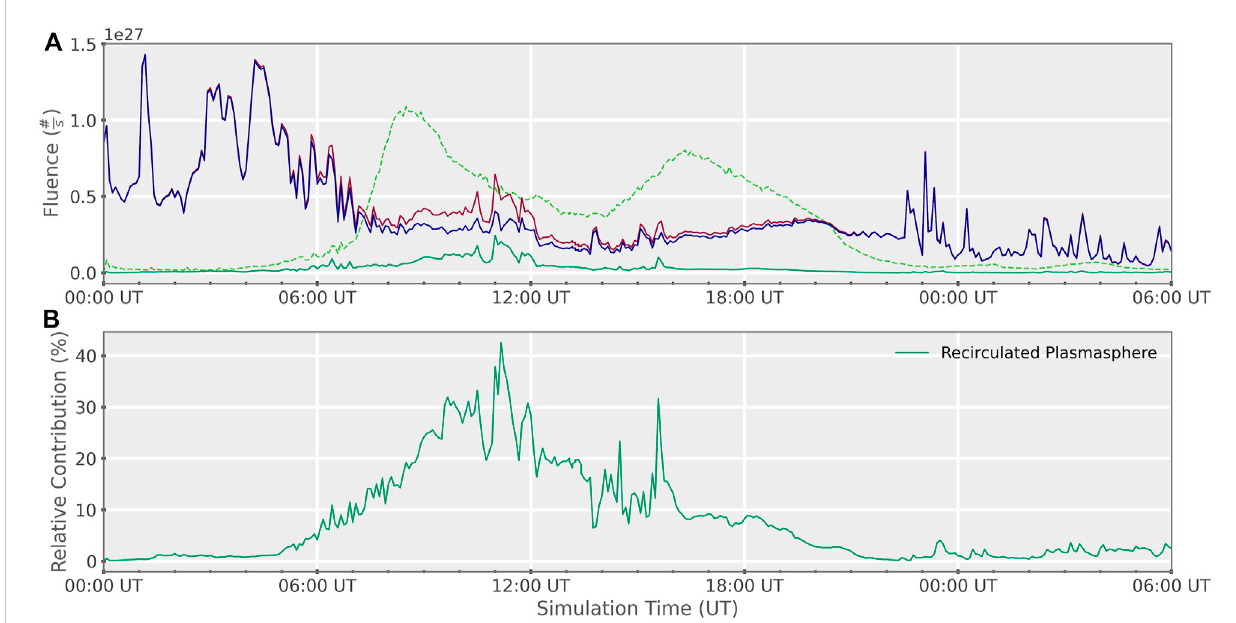
FIGURE 11 (A) Fluence of the BATS-R-US fl uids as they cross the measurement boundaries on the day and night side 1. “ Dayside Plasmasphere ” corresponds to the fl uence of the plasmasphere material through the dayside plume. “ Total Night Side ” refers to the total fl uence of all fl uids passing through the night side measurement boundary. “ Nightside Solarwind/High Lat Ionosphere ” refers to the fl uence of the combined solar and polar wind across the night side boundary. “ Nightside Plasmasphere ” refers to the fl uence of the recirculating plasmasphere through the night side measurement boundary. (B) Relative contribution of the recirculating plasmasphere to the total fl uence crossing the night side measurement boundary in the Idealized CIR event 1. At 0% there is no recirculating plasmasphere, at 50% the recirculating plasmasphere is contributing equally to the combined solar and polar